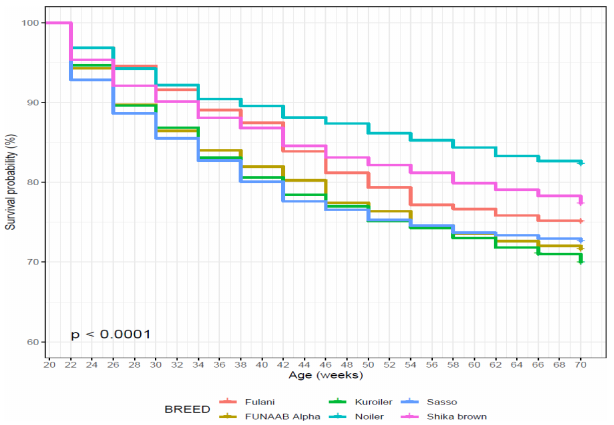
Figure 10. Effect of agroecology on survival performance of fe- male birds raised on-farm in ACGG Nigeria project zones (20–72 weeks) (2016–2018).